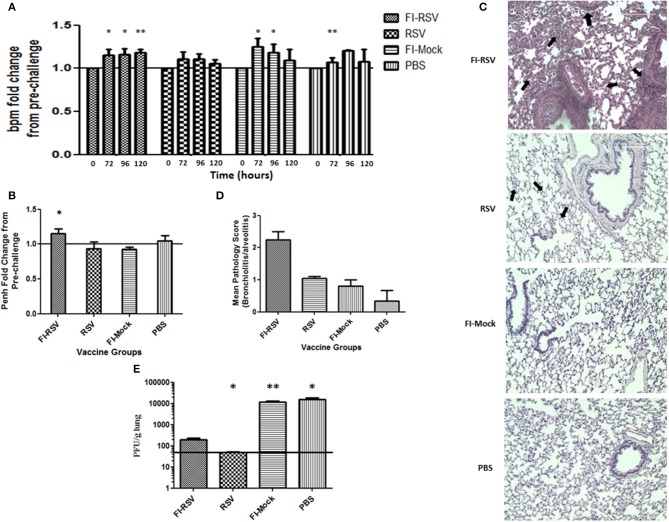
Development of VERD following RSV challenge of FI-RSV-immunized cotton rats. Vaccinated cotton rats were monitored daily for 5 days after RSV challenge for airway obstruction using a whole body plethysmograph (n = 6). Results are displayed as fold change from 0 h when challenged with RSV (day 49 of study) for (A) breaths per minute (bpm) and (B) Penh (120 h after viral challenge). Significant differences between time = 0 h post-challenge for each group and 72, 96, and 120 h of the respective group was assessed using one-way ANOVA, *p < 0.05, **p < 0.01. (C) Representative pictures of H&E-stained lung tissue obtained from animals in the indicated groups 5 days after challenge with RSV (40× magnification). (D) Lung pathology scores (bronchiolitis and alveolitis) of animals in the indicated groups 5 days after challenge with RSV. (n = 6) (E) Lung viral titres measured in animals in the indicated groups 5 days after challenge with RSV. Data are represented as mean ± SEM from two independent experiments (n = 6). Significant differences between FI-RSV vaccinated group and the other groups were assessed using one-way ANOVA, *p < 0.05, **p < 0.01.